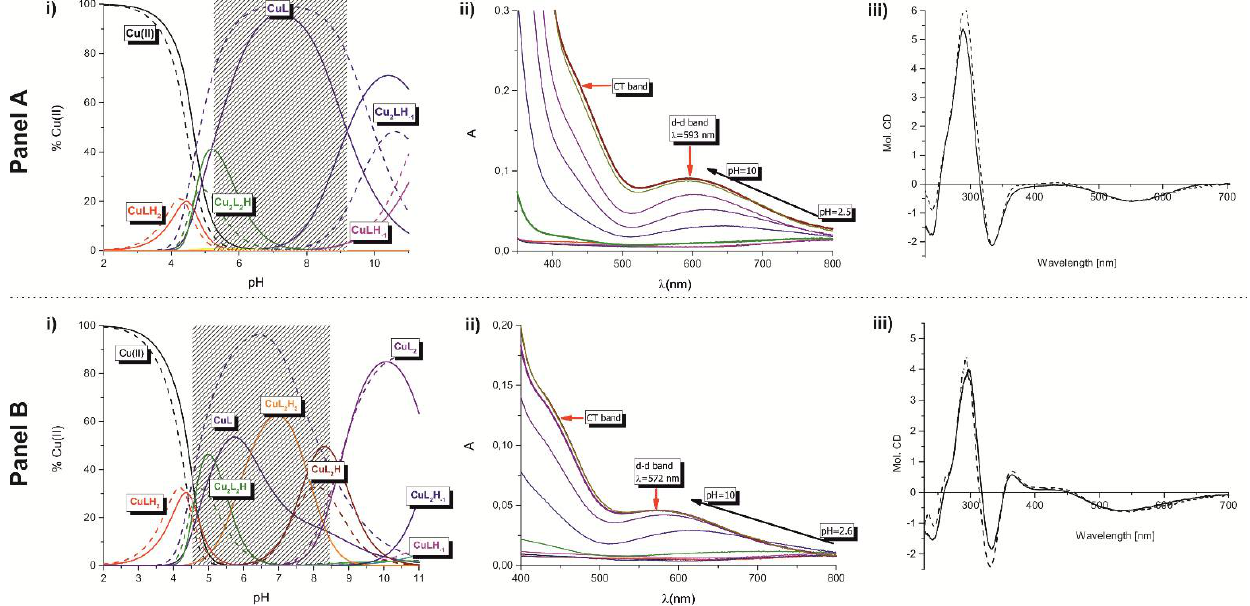
Figure 2. Panel A: ( i ) the species distribution curves for the 9a -Cu(II) system (solid line) and 10a -Cu(II) (dashed line) in dependence on pH, measured for the nL:nCu(II) = 1:1 molar ratio, ( ii ) the UV-Vis spectra in dependence on pH for the 9a , ( iii ) the CD (dashed line) and MCD (solid line) spectra of 10a with the nL:nCu(II) = 1:1 molar ratio at pH = 10.5. Panel B: ( i ) the species distribution curves for the 9a -Cu(II) (solid line) and 10a -Cu(II) (dashed line) system in dependence on pH, measured for the nL:nCu(II) = 2:1 molar ratio, ( ii ) the UV-Vis spectra in dependence on pH for the 9a , ( iii ) the CD (dashed line) and MCD (solid line) spectra of 10a with the nL:nCu(II) = 2:1 molar ratio at pH =